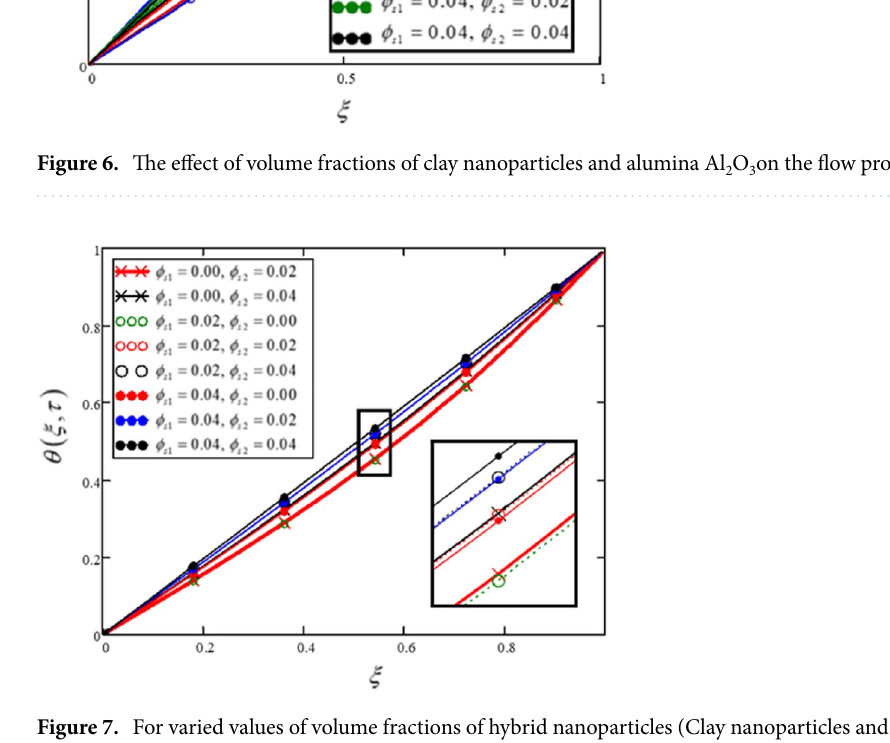
Figure 7. For varied values of volume fractions of hybrid nanoparticles (Clay nanoparticles and Alumina), the temperature profile